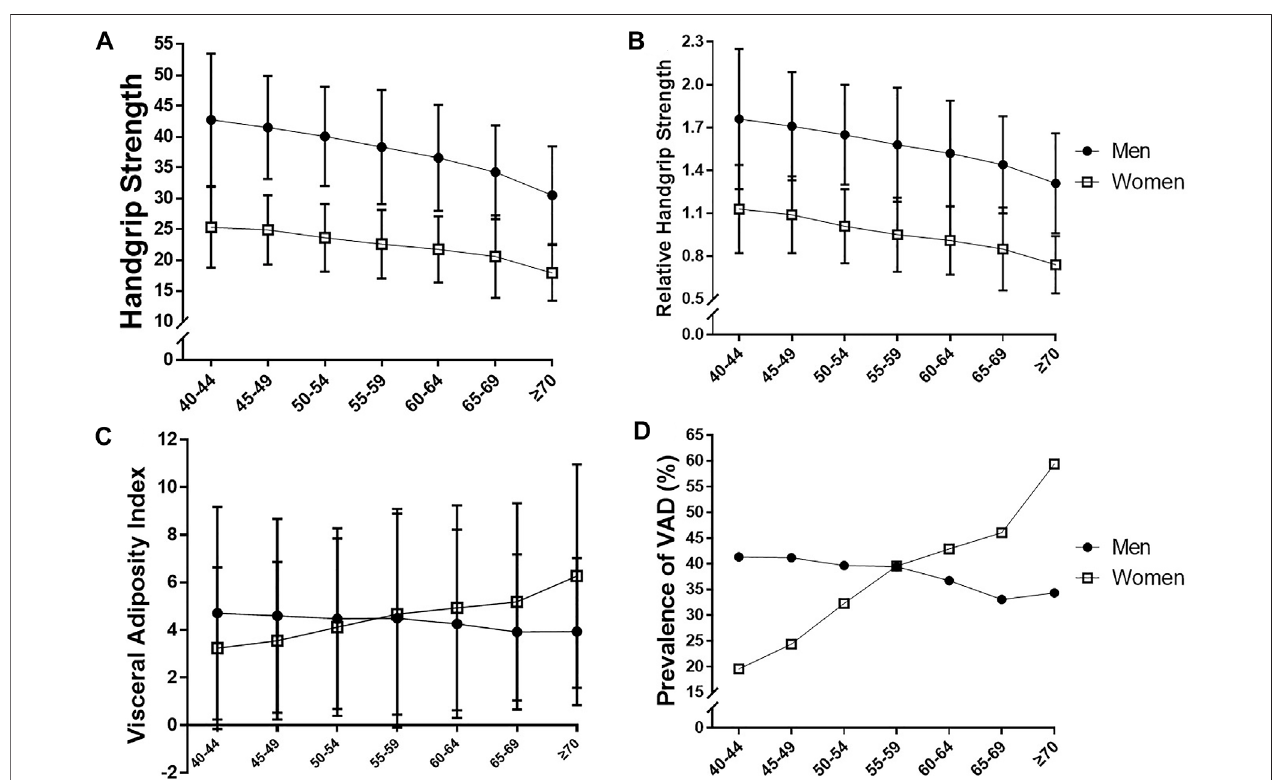
FIGURE 1 | Comparison of (A) handgrip strength, (B) relative handgrip strength, (C) visceral adiposity index, and (D) prevalence of visceral adipose dysfunction (VAD) according to age and sex.